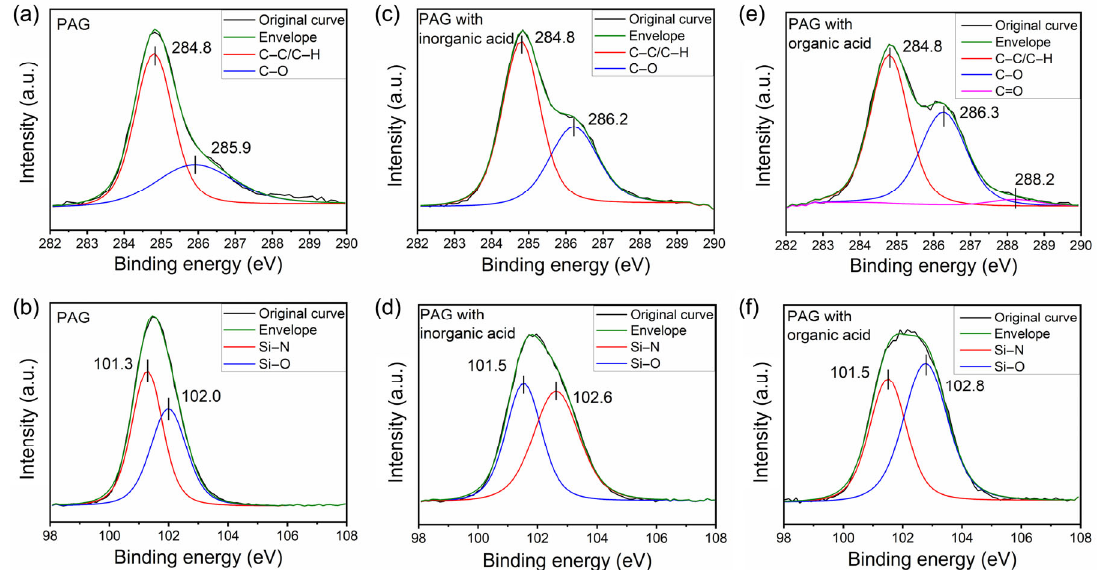
Fig. 6 XPS spectra of (a, c, e) C 1s and (b, d, e) Si 2p in the worn region on the Si 3 N 4 ball after lubrication with (a, b) original PAG aqueous solution, (c, d) PAG aqueous solution with inorganic acid, and (e, f) PAG aqueous solution with organic